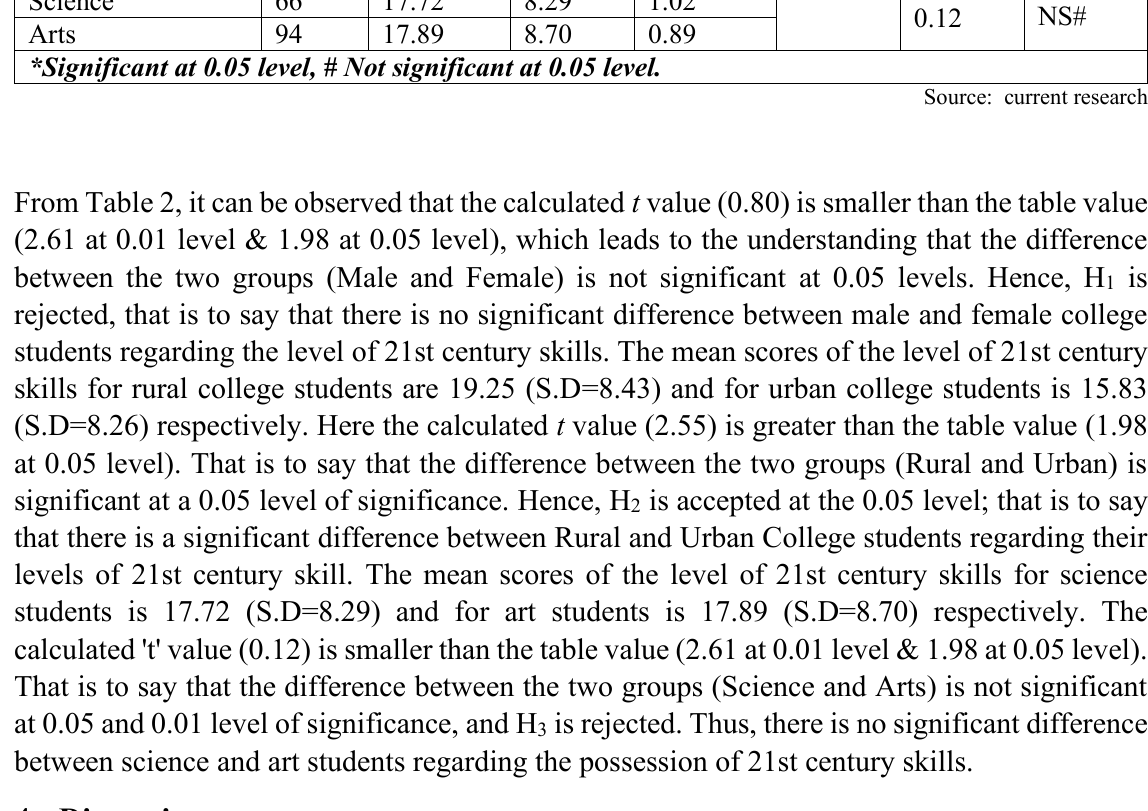
TABLE 2. SIGNIFICANCE OF DIFFERENCE BETWEEN VARIABLES N Pair of Comparison